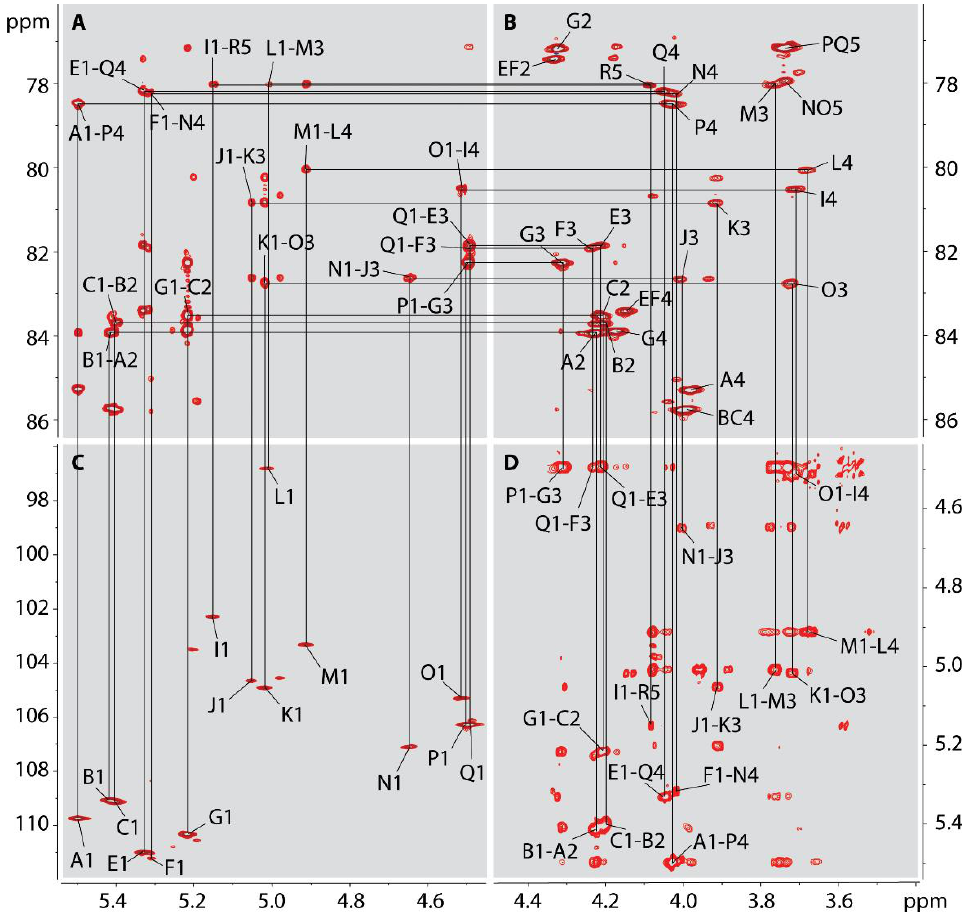
Figure 9. Partial 2-D 1 H- 13 C-HMBC ( A ), HSQC ( B , C ), and 1 H- 1 H-NOESY ( D ) NMR spectra of the Lcr polysaccharide. The figure shows inter-residue correlations used to determine the monosaccharide sequences of the core and O-antigens.